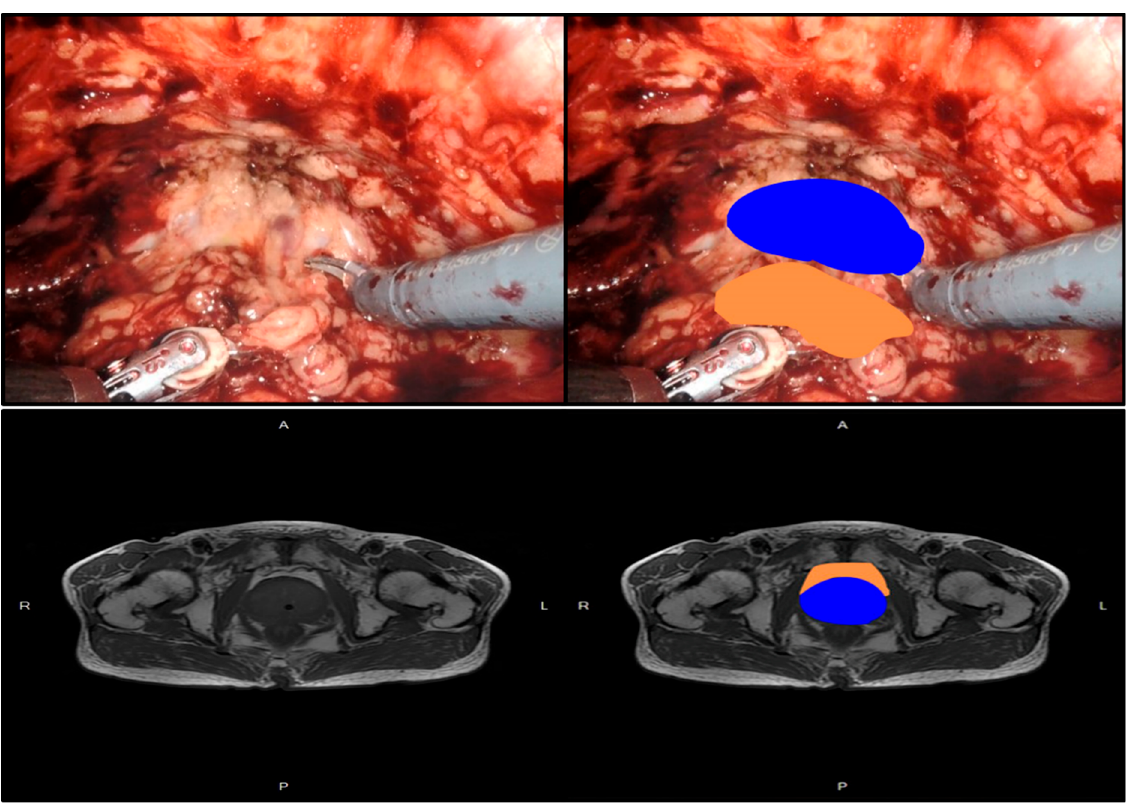
Figure 1. PPAT in robot-assisted radical prostate cancer surgery. The orange color in the image represents PPAT and the blue color represents prostate cancer.